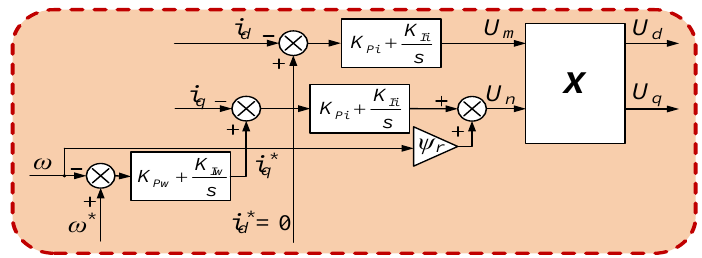
Figure 6. Traditional current